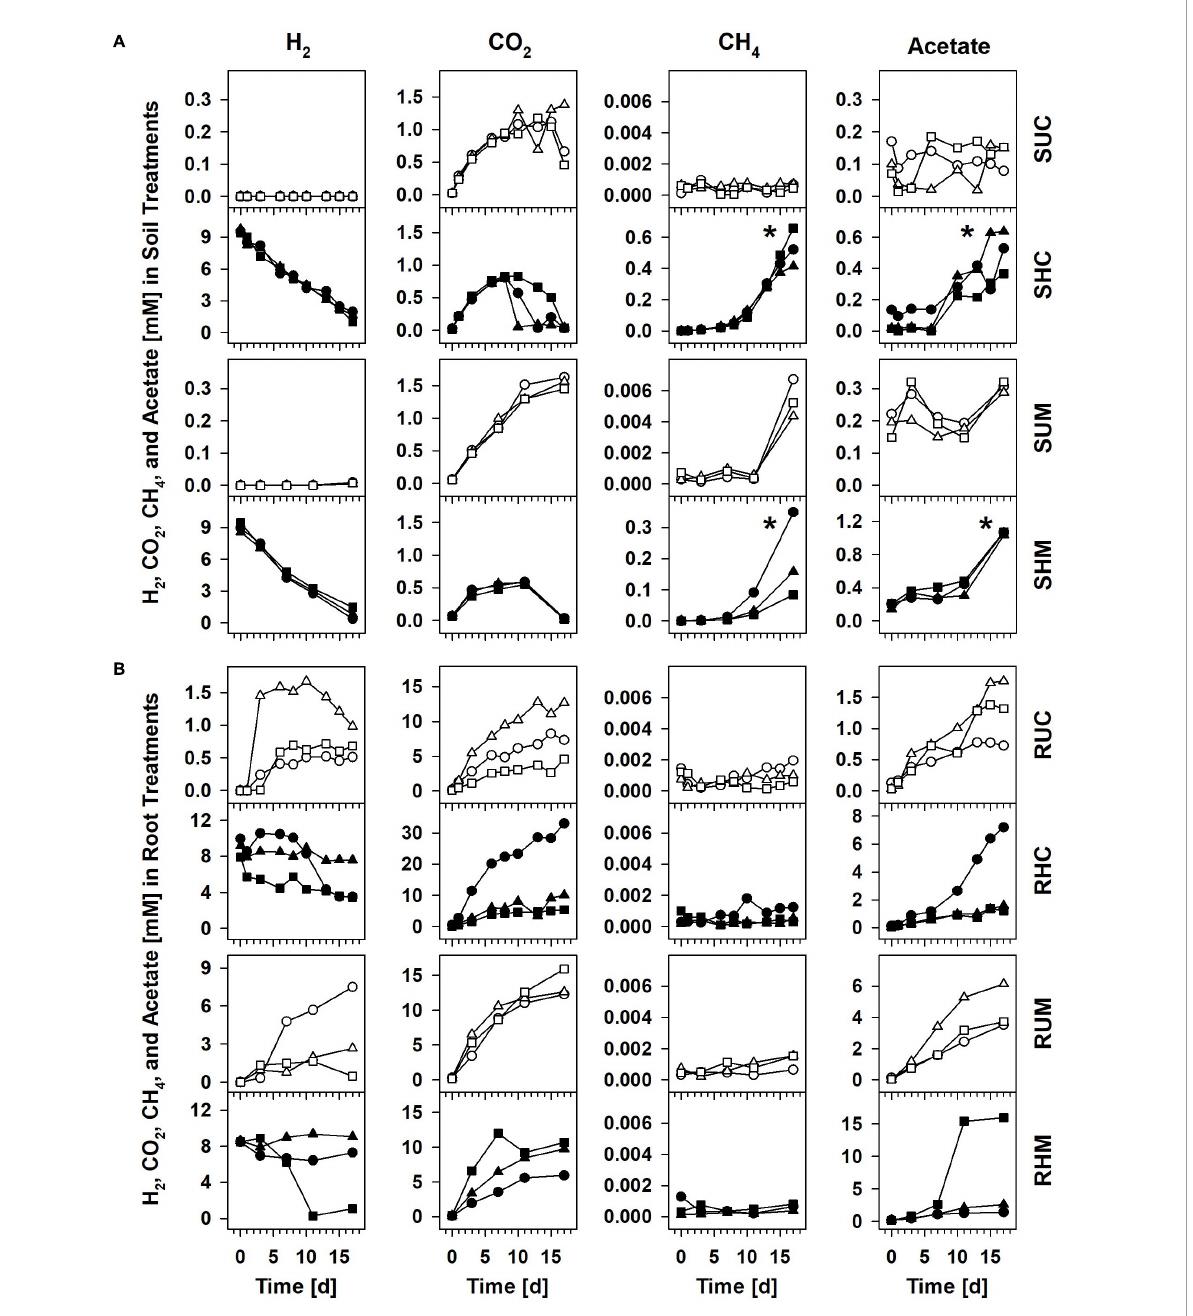
FIGURE1 Concentrations of H 2 , CO 2 , CH 4 , and acetate in soil treatments (A) and root treatments (B) . Treatment identifiers: SUC, unsupplemented Carex soil; SHC, H 2 supplemented Carex soil; SUM, unsupplemented Molinia soil; SHM, H 2 supplemented Molinia soil; RUC, unsupplemented Carex roots; RHC, H 2 supplemented Carex roots; RUM, unsupplemented Molinia roots; RHM, H 2 supplemented Molinia roots. Symbols: circles, replicate 1; triangles, replicate 2; squares, replicate 3. The asterisks indicate significant differences (one-sided Wilcoxon rank sum test; P ≤ 0.05) between the amounts of CH 4 and acetate formed in H 2 treatments and unsupplemented treatments during incubation. See Supplementary Figure 2 for ethanol, butyrate, propionate, and pH.